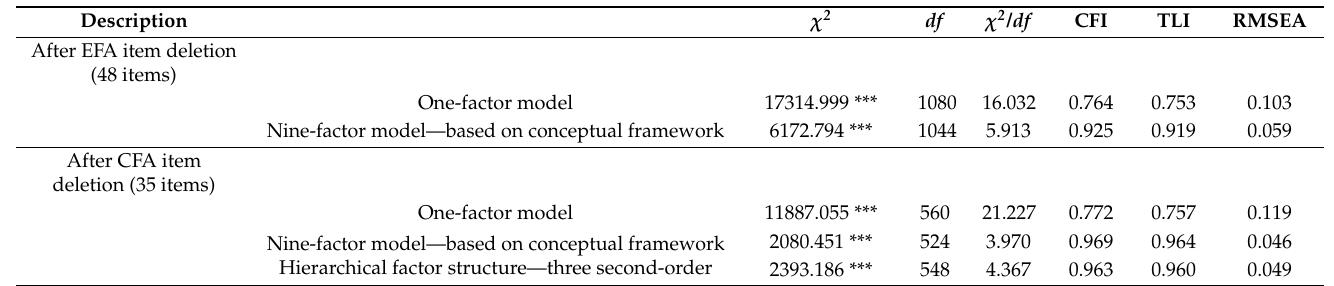
Table 4. Goodness-of-Fit Indices for Confirmatory Factor Models and Hierarchical Factor Models of C-FRS (Subsample B).